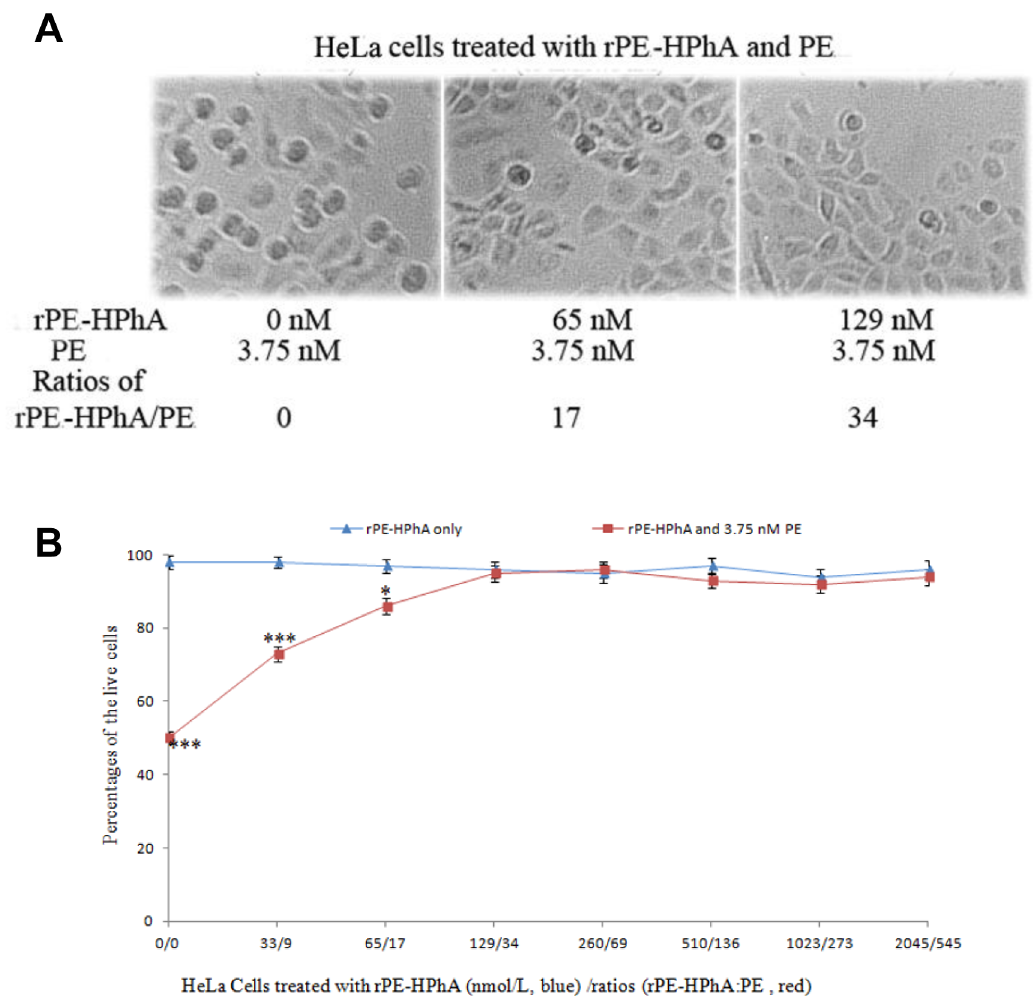
Fig 2. Cytotoxicity of rPE-HPhA. A) Effect of rPE-HPhA (0, 65 and/or 129 nmol/L) and PE (3.75 nmol/L) on HeLa cells killing. All images were magnified 100 times. B) Percentages of the live HeLa cells in different concentrations of rPE-HPhA analyzed by cell count. Blue bars represented the percentages of the living cells under the treatment of rPE-HPhA. Red bars represented the percentages of the living cells under the combined treatment of rPE-HPhA and PE. Asterisk represents the level of significance between low concentrations of rPE-HPhA (0, 33 and/or 65 nM) versus high concentrations of rPE-HPhA (more than 129 nM) in the presence of PE (3.75 nM) ( *** p < 0.001; * p < 0.05). Error bars represent mean ± SEM of three independent